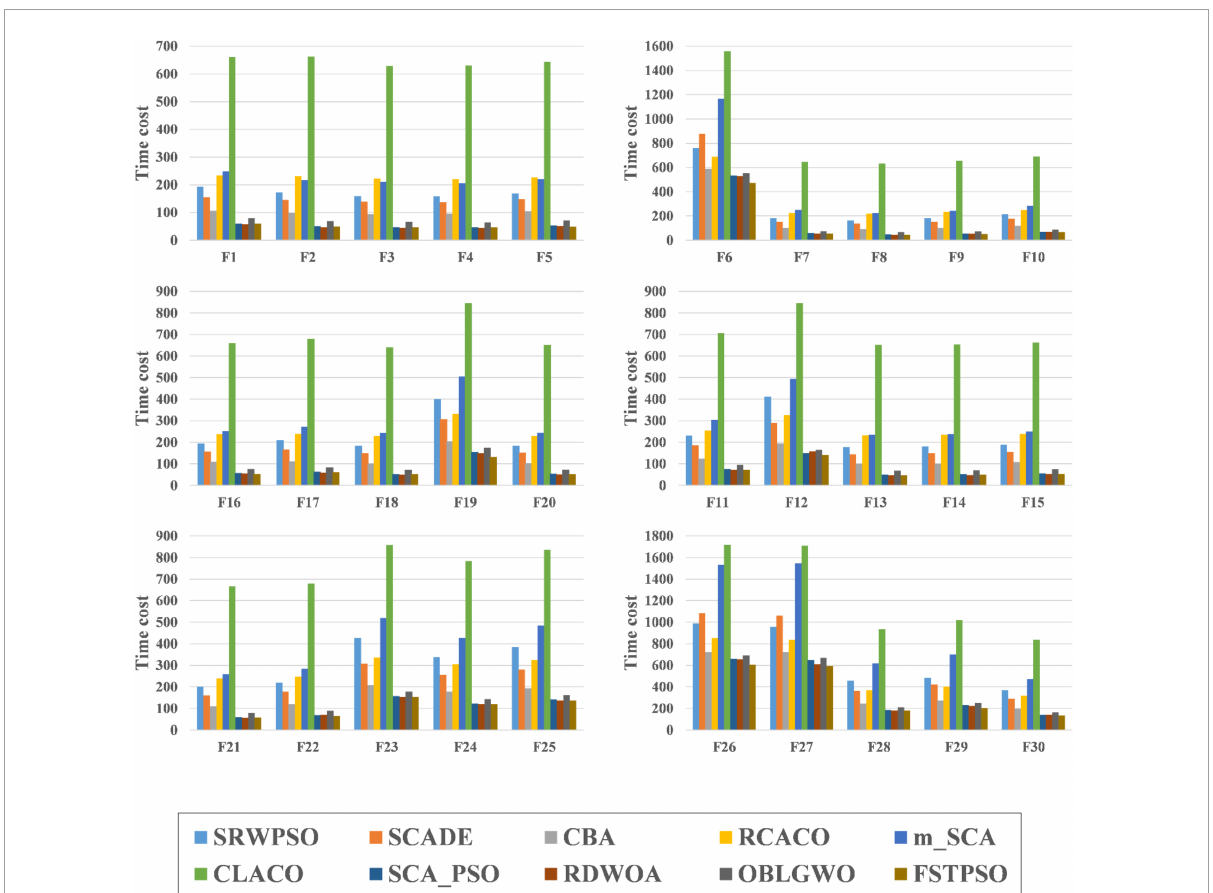
FIGURE12 The time complexity evaluation results of SRWPSO with famous variants.